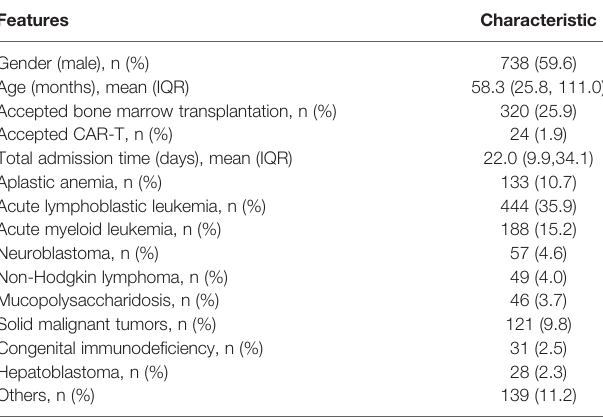
TABLE 1 | Characteristics of 1,238 included